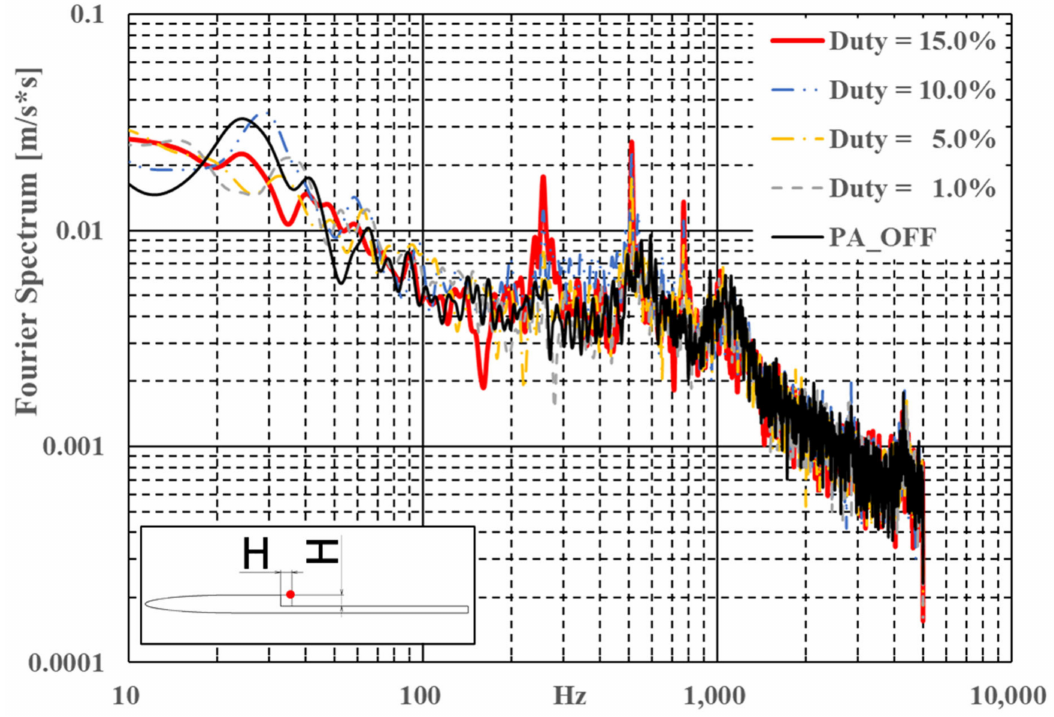
Figure 15. FFT Analysis (Fourier